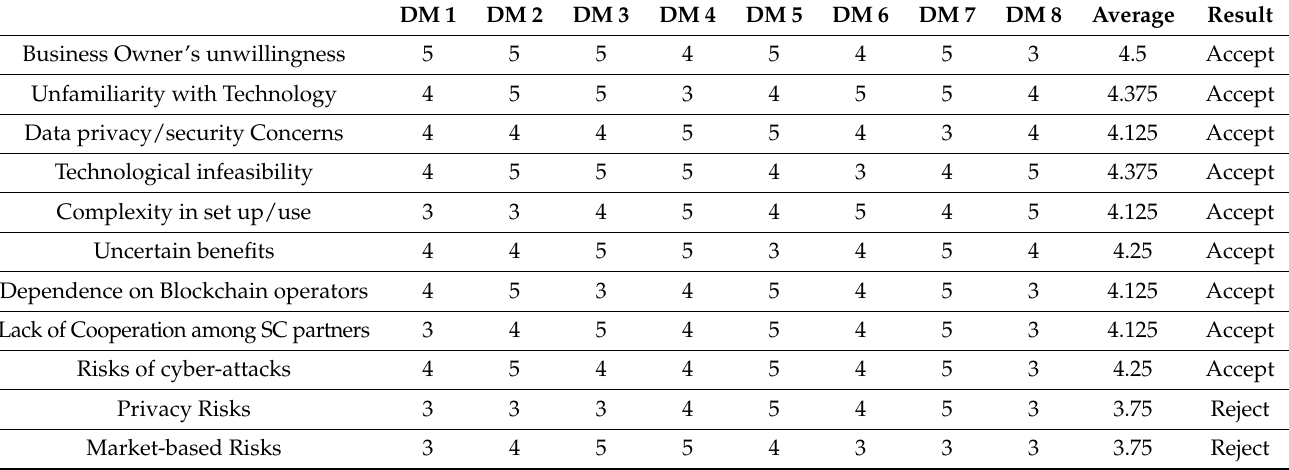
Table 3. The procedure of computation Delphi